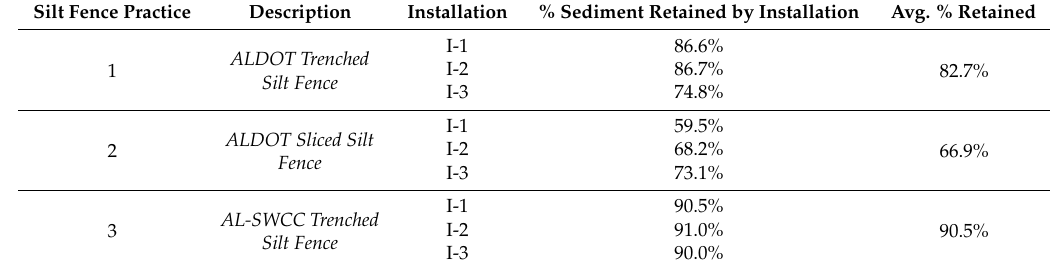
Table 2. Summary of Silt Fence Practice Sediment Retention Data.